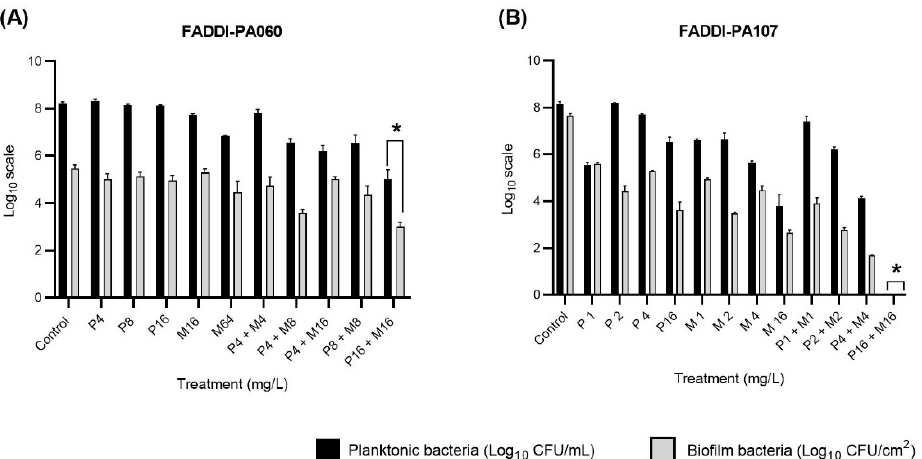
Figure 5. Planktonic and biofilm growth of MDR P. aeruginosa ; FADDI-PA060 ( A ) and FADDI-PA107 ( B ) following 24 h exposure to polymyxin B (P) and/or meropenem (M) in the dynamic biofilm model. Planktonic cell counts are a measure of observed viable cell counts per mL whereas biofilm cell counts are a measure of observed viable cell counts per cm 2 of the Teflon coupons (the aggregating surface for biofilm formation). One-way ANOVA with Kruskal–Wallis multiple comparisons versus control group * p < 0.05. Each experiment was performed in triplicate and data are presented as mean ± SD ( n = 3).